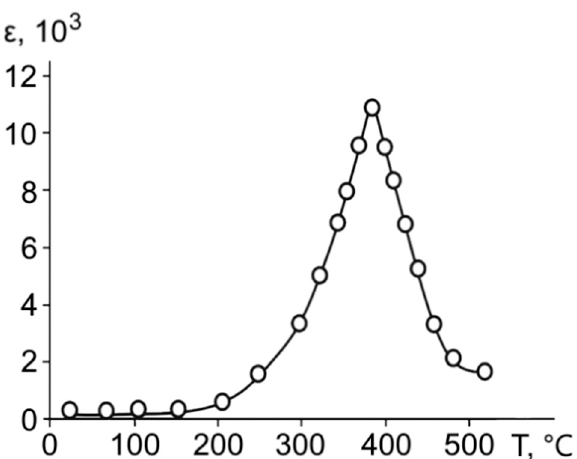
Figure 2. The temperature dependence of dielectric permittivity of the ferroelectric BaZrO 3 /BaTiO 3 superlattice under a measuring field with a frequency of 1 kHz.